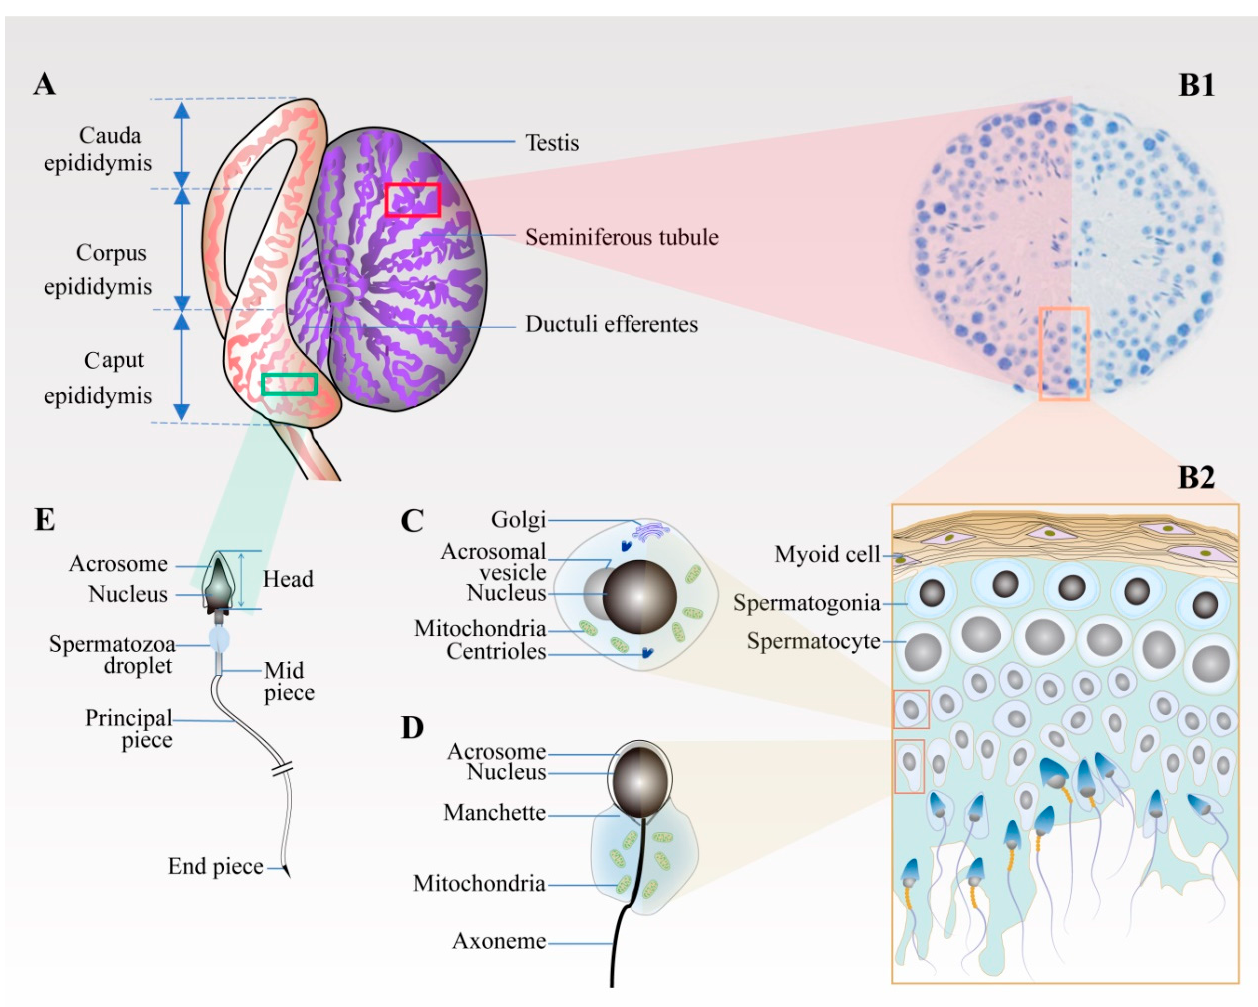
Figure 1. Schematic diagram of spermiogenesis in the testis and epididymis. ( A ) Testis and epididymis. Spermatogenesis mainly occurs on the spermatogenic epithelium inside the long and coiled seminiferous tubules comprising the testis. After leaving the testicle, the deformed sperm is stored in the epididymis through the ductuli efferentes testis. The epididymal microenvironment promotes the maturation of the sperm. ( B1 , B2 ) Cross-section of seminiferous tubule. ( B1 , B2 ) The cross-section and enlarged view of the seminiferous tubule, respectively. From the tube wall to the lumen, the spermatogenic cells are arranged in layers according to their types. Spermatogonia, primary spermatocytes, and secondary spermatocytes are located near the wall of the tube, whereas the round spermatids, elongated spermatids, and mature spermatozoa are located near the lumen. ( C ) Round spermatid. The haploid round sperm cells are formed after the second meiosis. ( D ) Elongated spermatid. Round spermatids develop into elongated spermatids through a series of processes, including the gradual aggregation and specialisation of Golgi bodies into acrosomes and the extension of centrioles into tail flagella. ( E ) Epididymal sperm. Spermatozoa acquire their fertilising ability and forward motility properties in the epididymis.